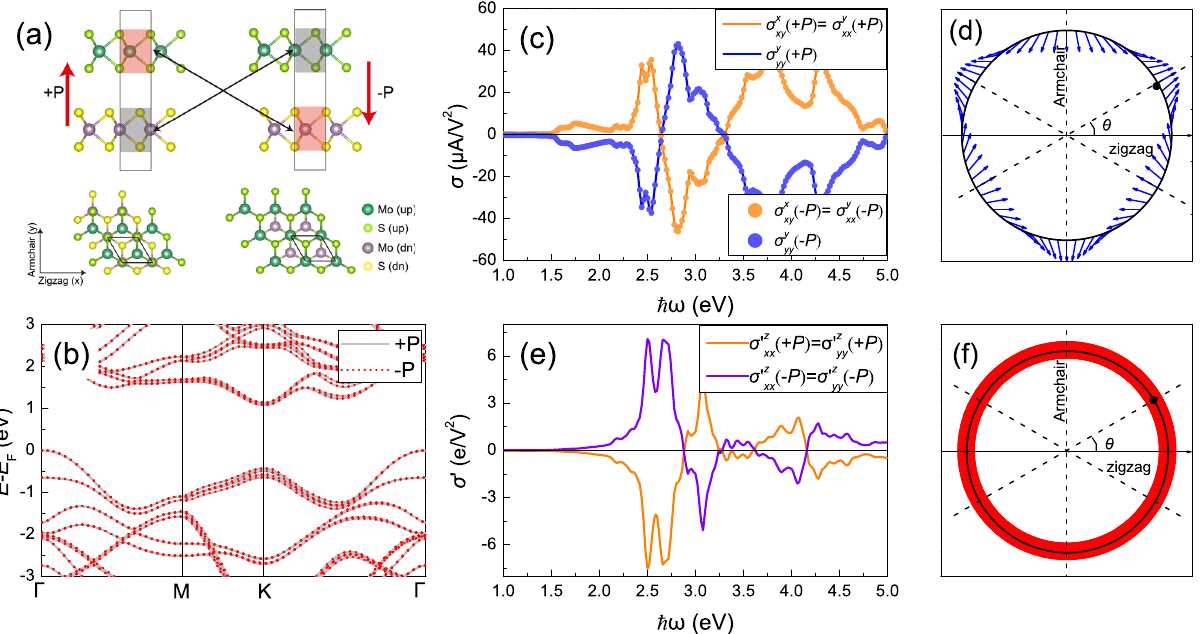
Fig. 2 Calculated results of ferroelectric bilayer MoS 2 . a Crystal structures of ferroelectric states (upper panel: side view, lower panel: top view). The arrows denote the transformation of the + P and – P states by interlayer b M xy symmetry. The de fi nitions of + P and – P states are adopted from ref. 24 . b Band structure of + P and – P states. c In-plane and e out-of-plane BPVE coef fi cients. d In-plane BPVE photocurrent and f out-of-plane BPVE polarization (in arbitrary unit) with the direction of normal-incidence polarization of light in the + P states. θ in d and f is the azimuthal angle of the polarization of light relative to the x axis, and the dash lines mean the vertical mirror